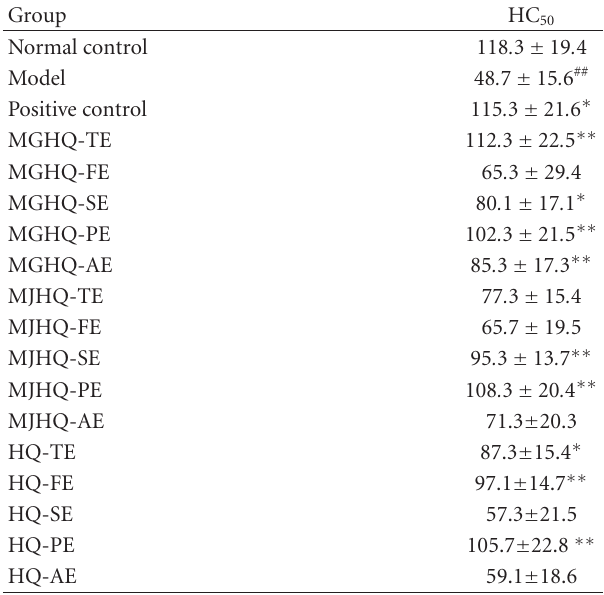
Table 6: E ff ects of di ff erent extracts on mice serum hemolysin. Group HC 50 Normal control 118 . 3 ± 19 . 4 Model 48 . 7 ± 15 . 6 ## 115 . 3 ± 21 . 6